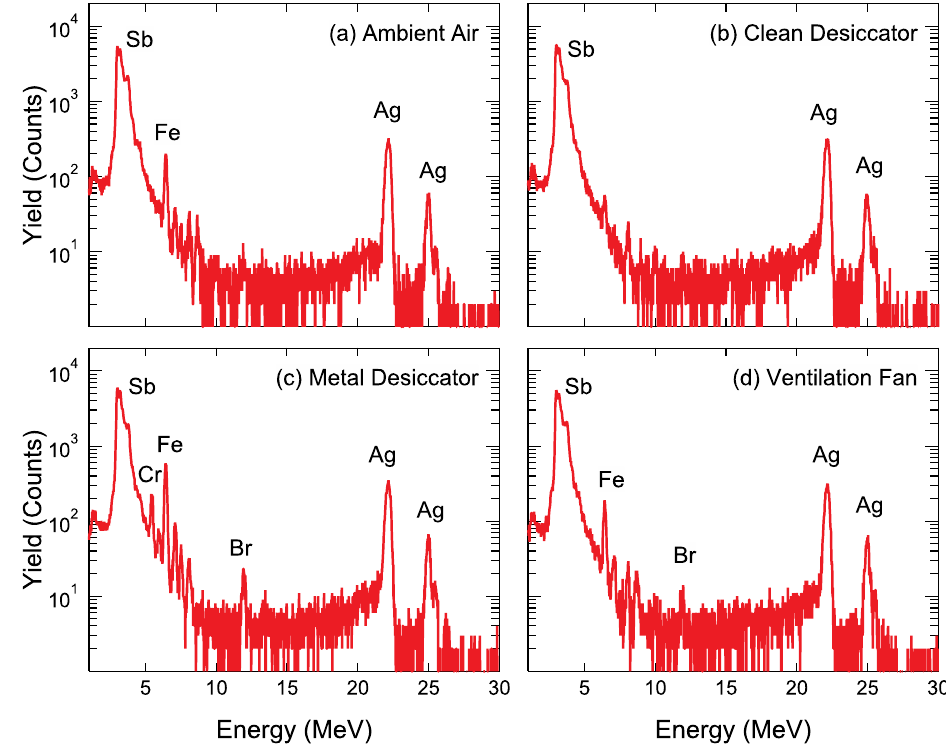
Figure 5. Particle-induced X-ray emission (PIXE) spectra of Ag/polyethylene naphthalate (PEN) stored ( a ) in ambient air, ( b ) inside the clean desiccator, ( c ) inside the metal desiccator and ( d ) near the ventilation fan for 28 days.